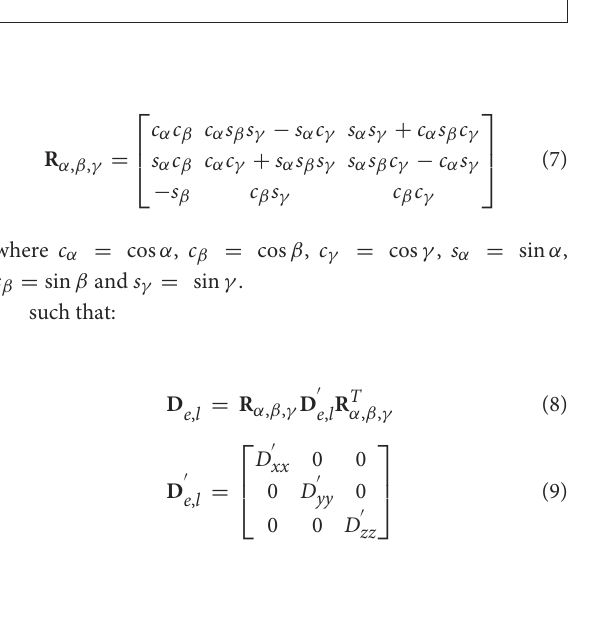
FIGURE1 Illustration of simulation domain for 2D anisotropic diffusion verification problem with a rectangular source at the center, red symbols identify observation points and the olive-colored ellipse is a schematic representation of the contaminant plume (A) and mesh (B)